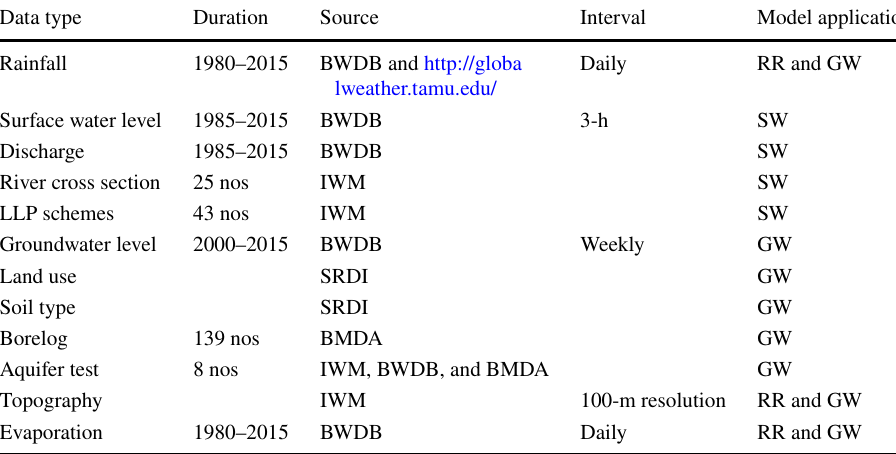
RR Rainfall–runoff, GW groundwater, SW surface